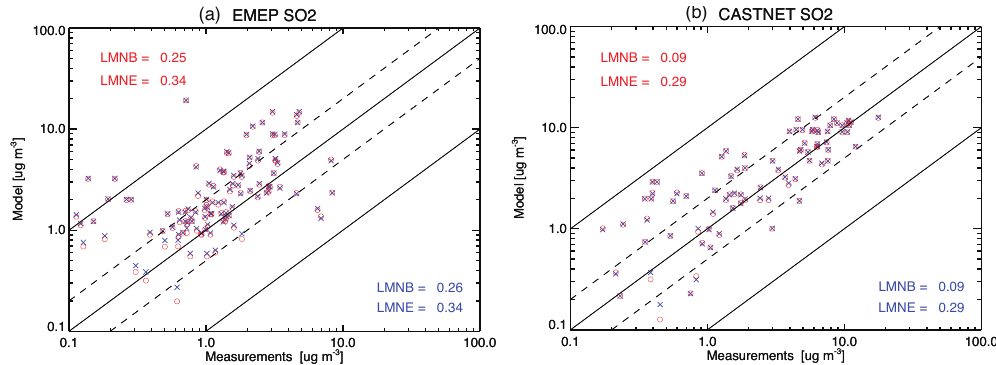
Figure 2. Scatter plot of annual-mean surface SO 2 concentrations (µgm − 3 ) for the model (red for ModelE2-TOMAS and blue for ModelE2- OMA) compared to the observations in the EMEP (European Monitoring and Evaluation Programme, Lovblad et al., 2004; (a) ) and CAST- NET (Clean Air Status and Trends Network, Malm et al., 2002; (b) ) networks. Log-mean normalized bias (LMNB) and log-mean normalized error (LMNE) are